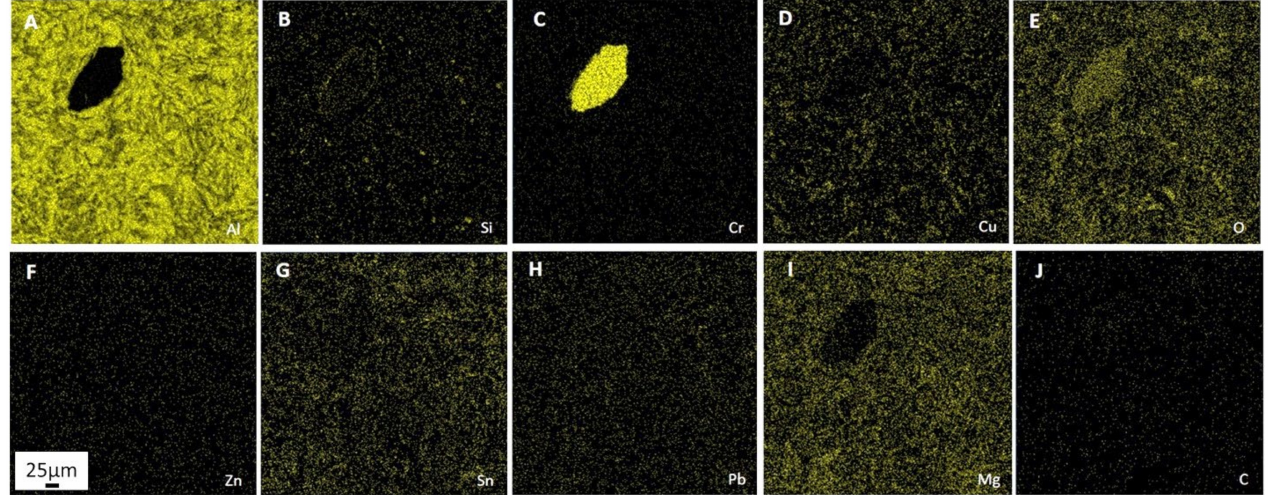
Figure 5. SEM-EDS elemental distribution maps for aluminum ( A ), silicon ( B ), chromium ( C ), copper ( D ), oxygen ( E ), zinc ( F ), tin ( G ), lead ( H ), magnesium ( I ) and carbon ( J ) in Al–Cr alloy. The scale in Figure F also applies to rest of images (scale: 25 µ